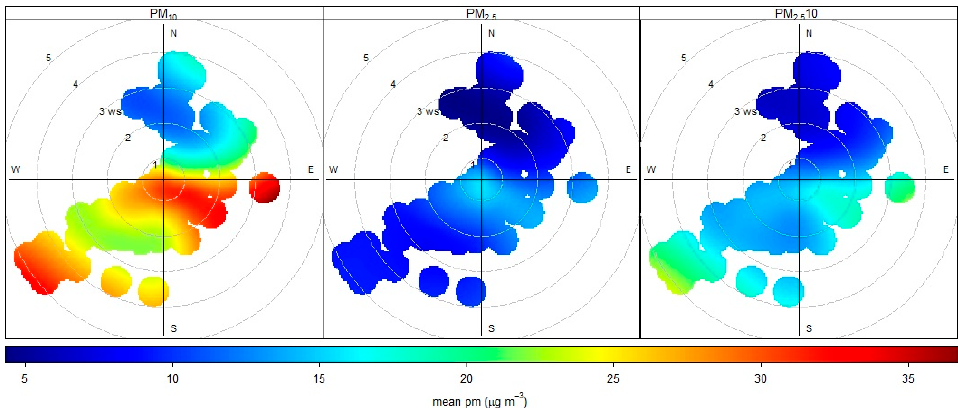
Figure 6. Polar plot for particulate matter (PM) at the measuring station on Košická Street from 19th to 25th April 2018 (ws—wind speed).